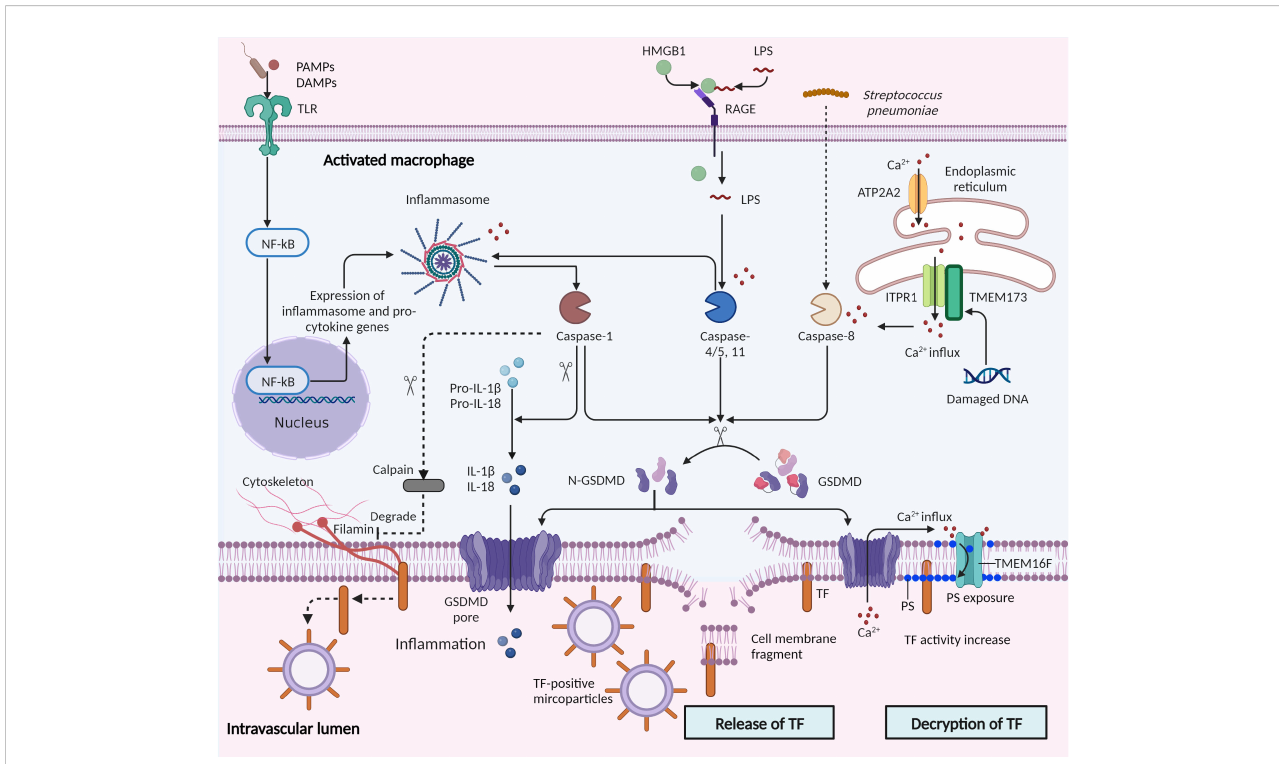
FIGURE 3 Control of tissue factor by pyroptosis in sepsis. Pyroptosis is stimulated by microbial infections and non-infectious stimuli, including host factors in sepsis. Canonical and non-canonical pyroptosis are both involved in tissue factor (TF) control. In canonical pyroptosis, pattern recognition receptors (PRRs) recognize pathogenic stimuli, and in fl ammasome complexes are assembled, which activate caspase-1 and then cleave pro-IL-1 b and pro-IL-18. Intracellular LPS directly binds and activates caspase-11. Subsequently, the activated caspases-1/11 cleave the gasdermin D (GSDMD) into the N-terminal of GSDMD (N-GSDMD), forming pores in the cell membrane. IL-1 b and IL-18 are then released through the pores and pyroptotic cell death occurs through osmotic lysis. TF is released in microparticles by the osmotic cell rupture in pyroptotic macrophages. In addition, caspase-1 may mediate TF release in another mechanism: activation of caspase-1 facilitates activation of calpain, degrading fi lamin in macrophages and thereby severing bonds between the cytoskeleton and TF. Furthermore, activation of transmembrane protein 173 (TMEM173) by infection-induced DNA damage mediates TF